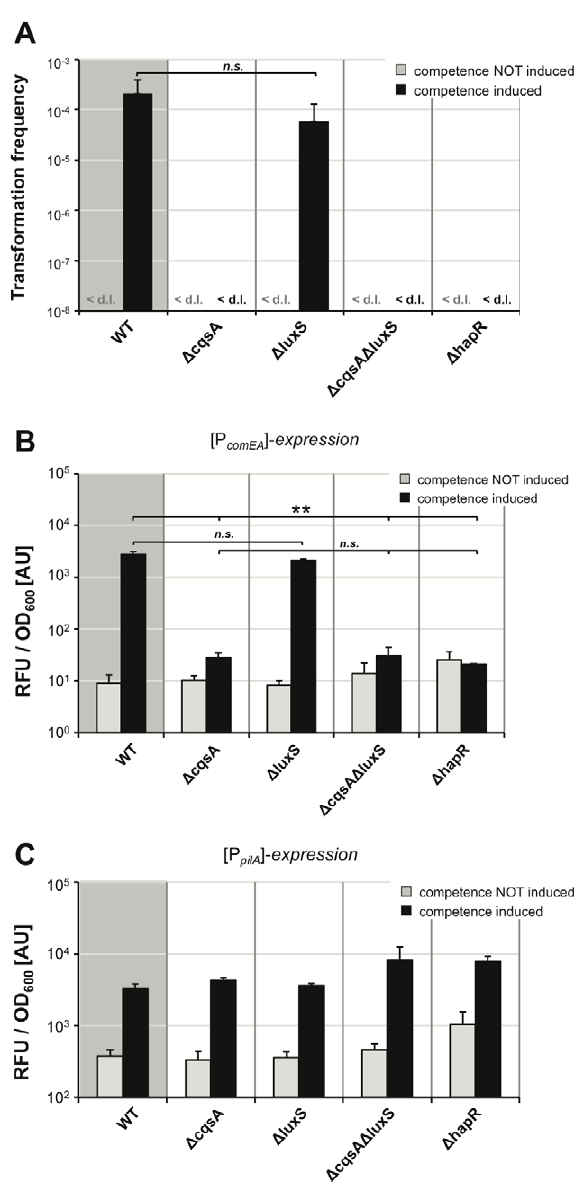
Figure 4. Quorum sensing only regulates a subset of compe- tence genes. The tfoX -expression construct was transferred onto the chromosome of mutant V. cholerae strains, which were defective in the quorum-sensing circuit. Strains were grown in LB medium with or without 0.02% arabinose and tested for natural transformability (panel A), comEA (panel B), and pilA promoter-driven FP expression (panel C) as described for Figure 3. Experiments were repeated at least three times. Statistically significant differences were calculated using the Student’s t test. * P , 0.05, ** P , 0.01, n.s. =not significant. , d.l.=below detection limit.